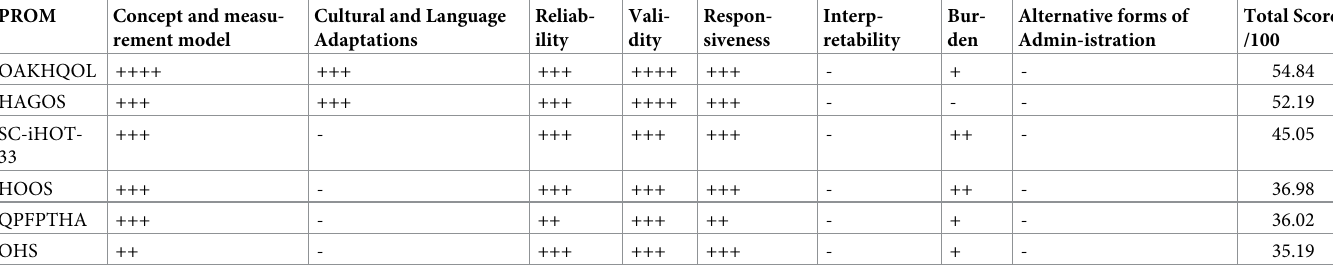
Table 2. Standardized assessment of measurement attributes of Chinese cross-culturally adapted PROMs using